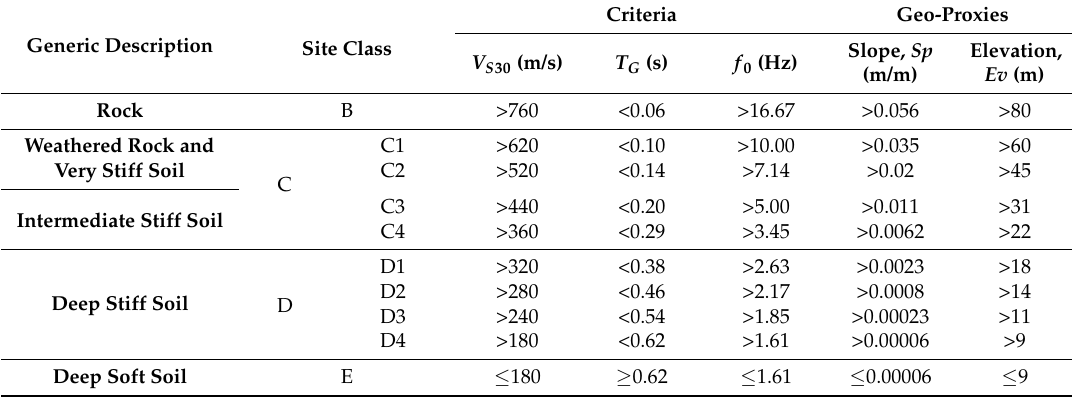
Table 5. Geo-proxy-based empirical site classification proposal according to the slope and elevation for domestic